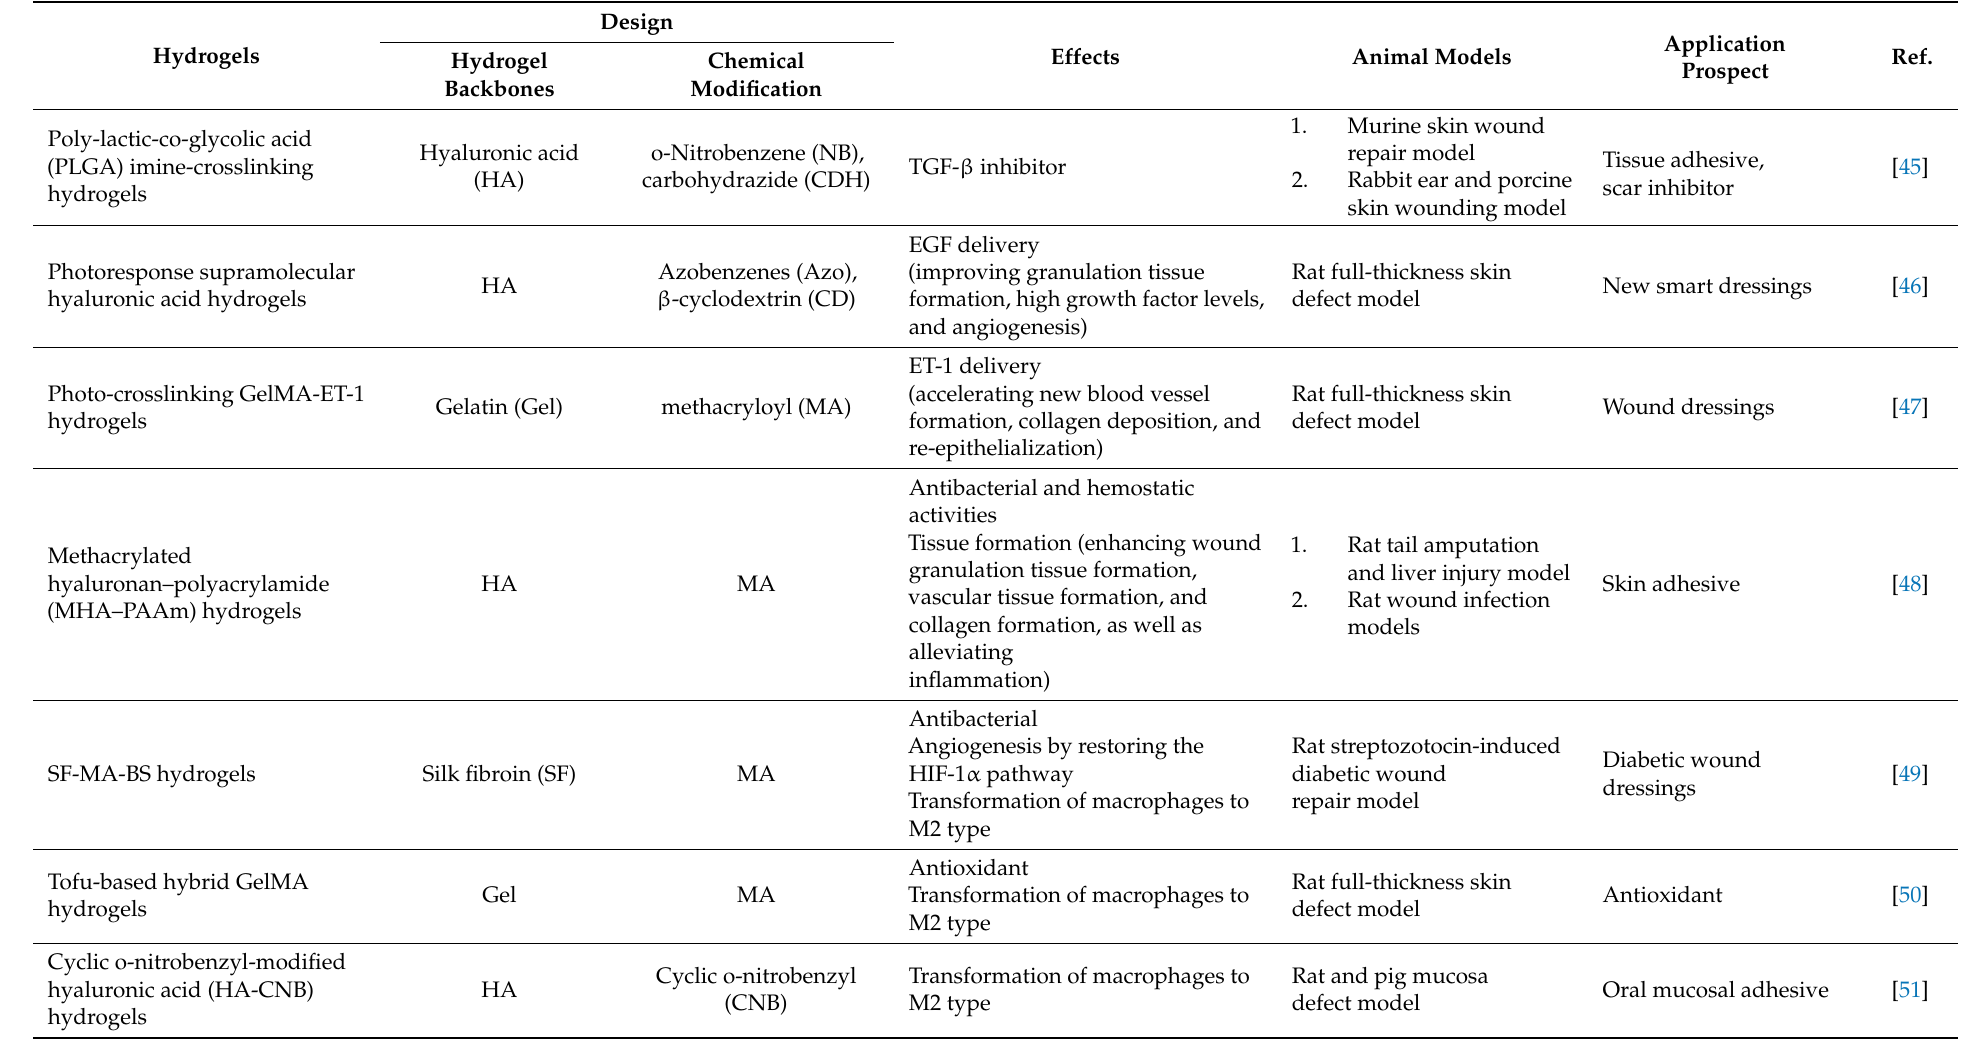
Table 1. Photo-crosslinking hydrogels for wound